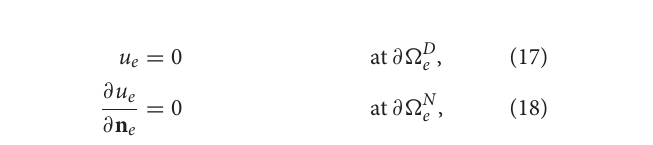
FIGURE 2 | Illustration of a tissue block, 1 , containing a number of cells (orange) and a surrounding extracellular space (red). In Step 1 of the derivation we approximate the discontinuous intracellular space (A) consisting of individual cells connected by gap junctions by a continuous intracellular space (B)